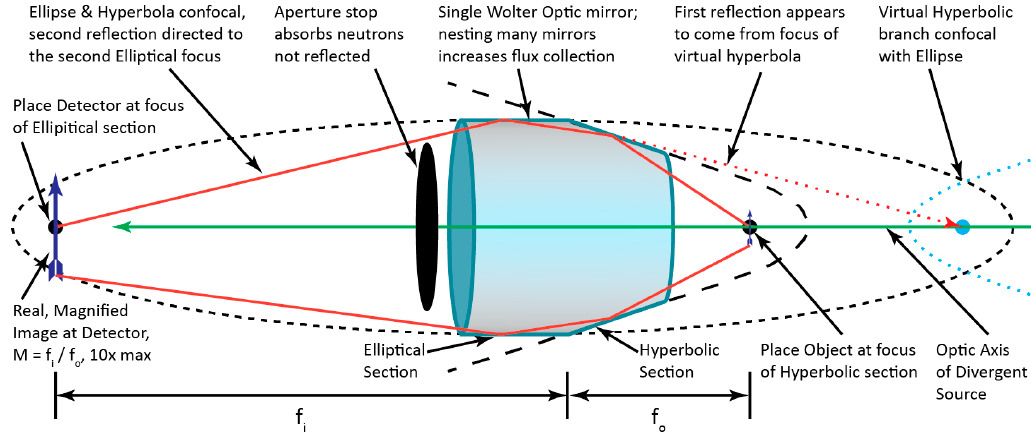
Figure 1. Schematic diagram of a Wolter type I optic composed of a confocal hyperboloid and ellipsoid.